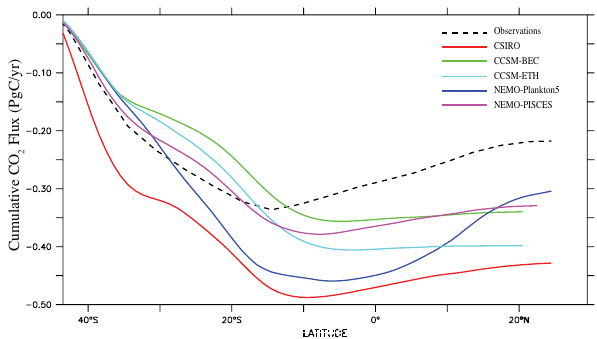
Fig. 5. The cumulative, zonally integrated, annual mean CO 2 up- take (30 ◦ N–44 ◦ S) from the biogeochemical ocean models and ob- servations (dashed line) (PgCyr − 1 ) . Negative values reflect sea–air fluxes into the